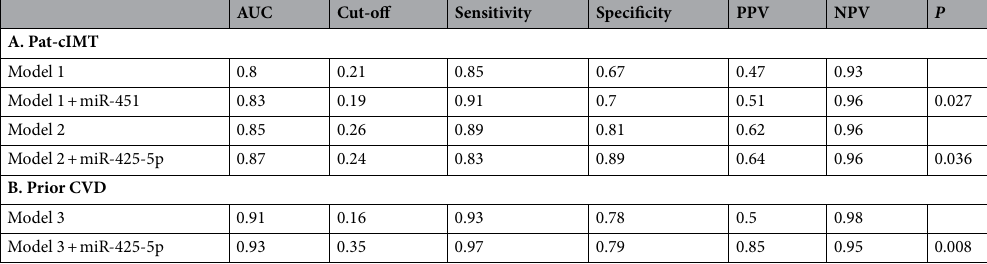
Table 3. ROC analysis parameters of pathological cIMT (A) and prior CVD (B) logistic models. ROC analyses were performed by logistic regression analysis applied to women (model 1) and to men (model 2 and 3) with or without inclusion of candidate miRs expression. Models were initially adjusted for age, RA disease onset, BMI, ischemic heart disease, peripheral artery disease, ictus, creatinine, and treatments. P values were obtain from the Likelihood Ratio test. AUC = area under the curve. PPV = positive predicted value. NPV = negative predicted value. P = p value.